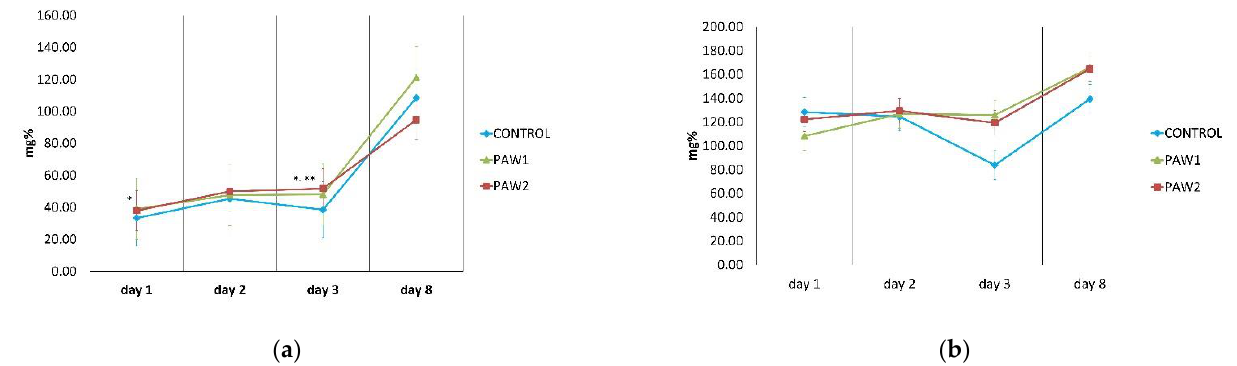
Figure 6. Effect of PAW treatment on the free ( a ) and bound ( b ) phenolic contents in Triticum aestivum L. cv. Glosa sprouts (days 1, 2, and 3) and shoots (day 8) ; * significant difference ( p < 0.05) between control and PAW1; ** significant difference ( p < 0.05) between control and PAW2. Each point represents the mean ± SD of three determinations.